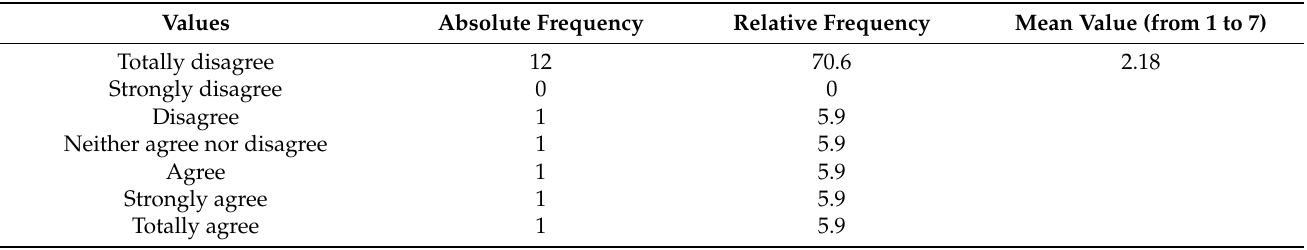
Table 6. Analysis of the results for item 6: “Women and men do not share the same leadership